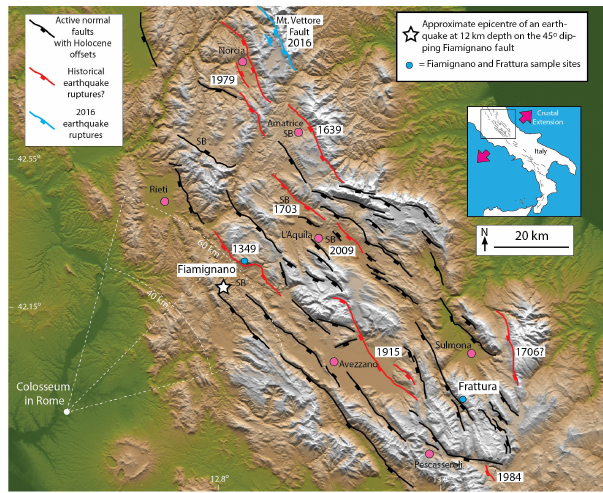
Figure 8. Location map of the central Apennines and the Fi- amignano and Frattura sample sites. Holocene active faults and his- torical ruptures adapted from Roberts and Michetti (2004), Pace et al. (2006), Cowie et al. (2017), and Mildon et al. (2017).